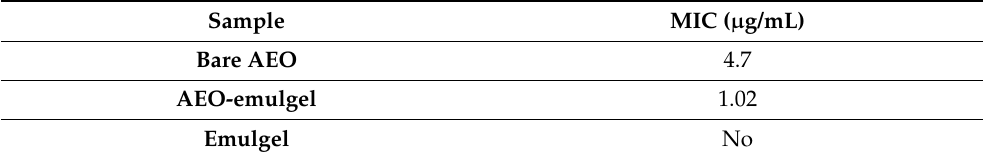
Table 2. Comparative MIC determination of the different compounds against E-coli .